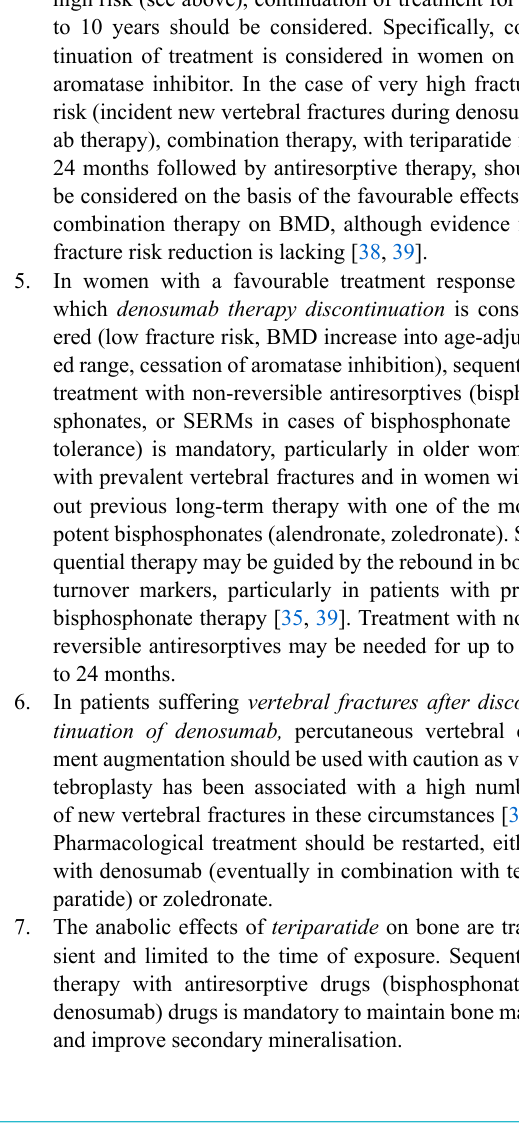
Figure 1: Approach to the management of postmenopausal women on anti-osteoporotic therapy. 1 High risk defined as (a) hip, spine or multi- ple fractures before or during therapy; (b) femoral neck T-score <˗2.5 SD if age <65 years, <-2.0 SD if age >65 years and/or frequent falls; (c) continuing hormone ablative therapy (e.g., aromatase inhibition, androgen deprivation therapy); (d) secondary osteoporosis, continuing gluco- corticoid therapy.BP =bisphosphonate; Ca/VD = calcium and vitamin D supplementation; Dmab, denosumab; DXA = densitometry; SERM = selective oestrogen receptor modulator; TPT =